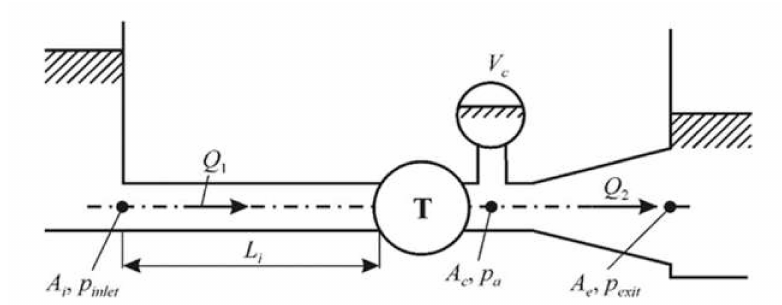
Figure 14. Scheme of the hydraulic parts of the